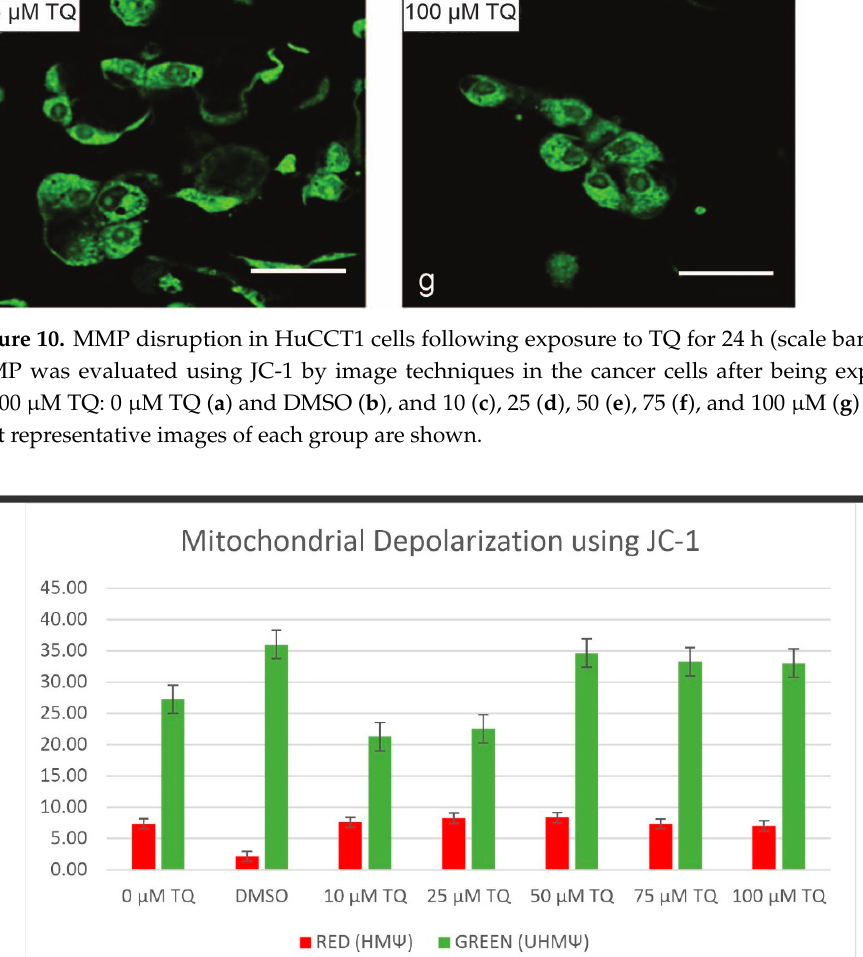
Table 4. Rodent Models targeting the Therapeutic Potential of TQ.